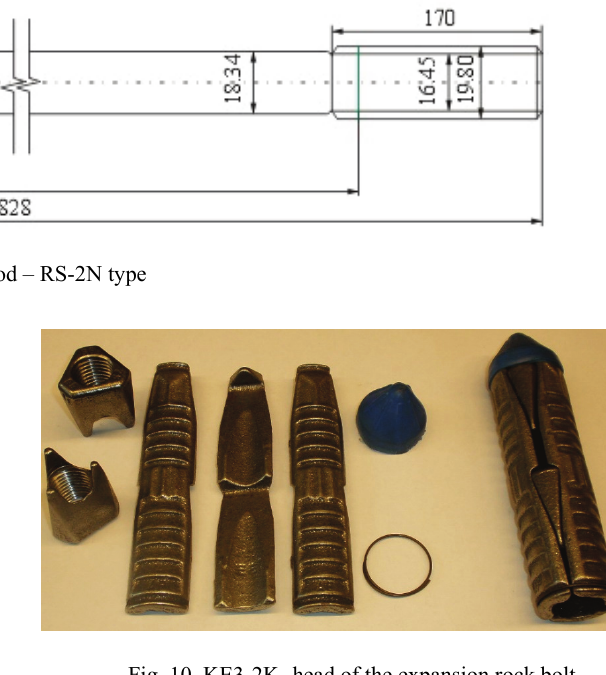
Fig. 10. KE3-2K- head of the expansion rock bolt